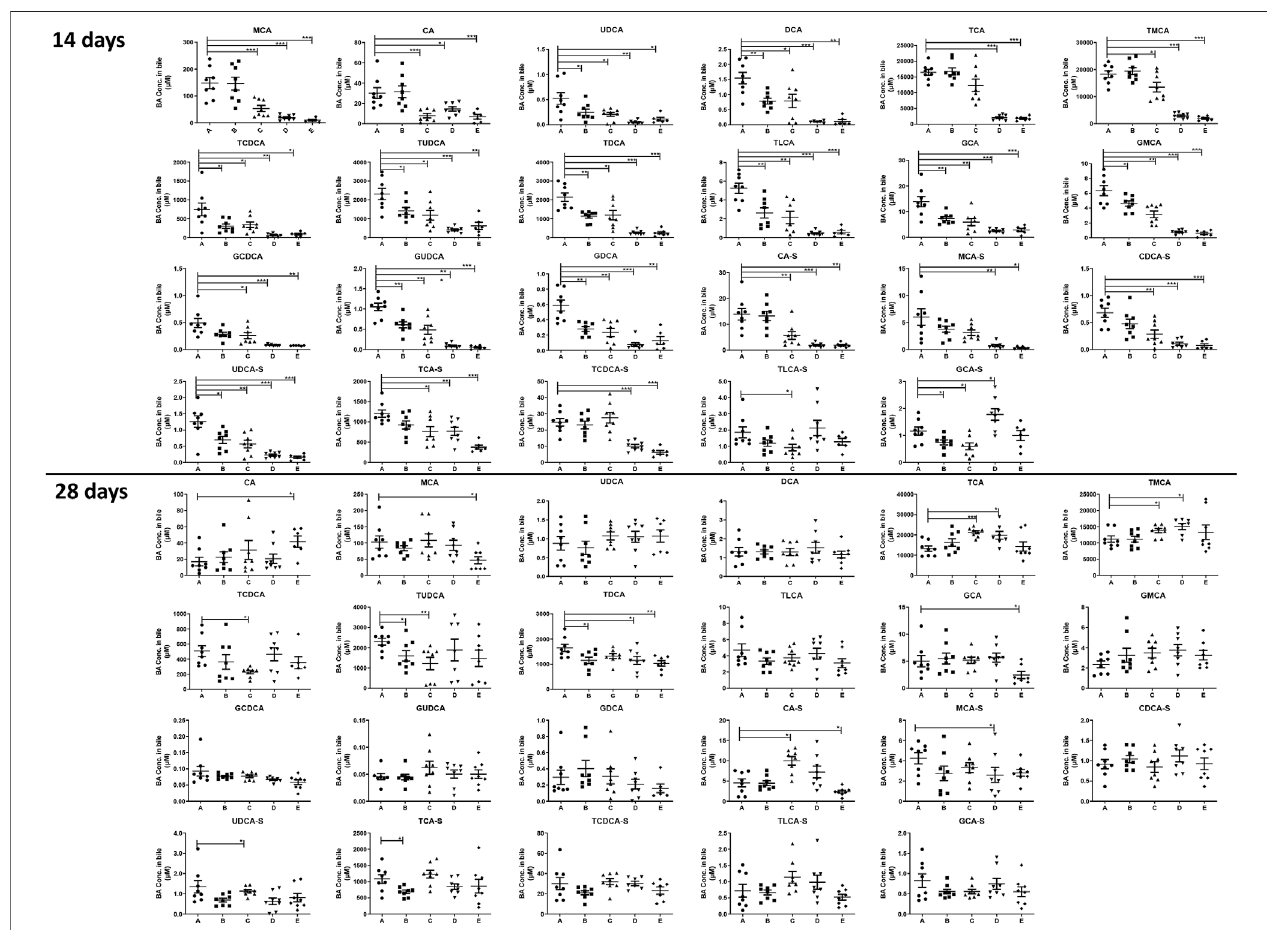
FIGURE 3 | Concentration of the individual BAs in the mouse bile after the anthraquinones or PMR consumption for 14 or 28 days (A: control, B: emodin, C: chrysophanol, D: physcion, E: PMR). The data are expressed as the mean ± SD (n = 6 – 8). * p < 0.05, ** p < 0.01, *** p < 0.001 compared with control group.